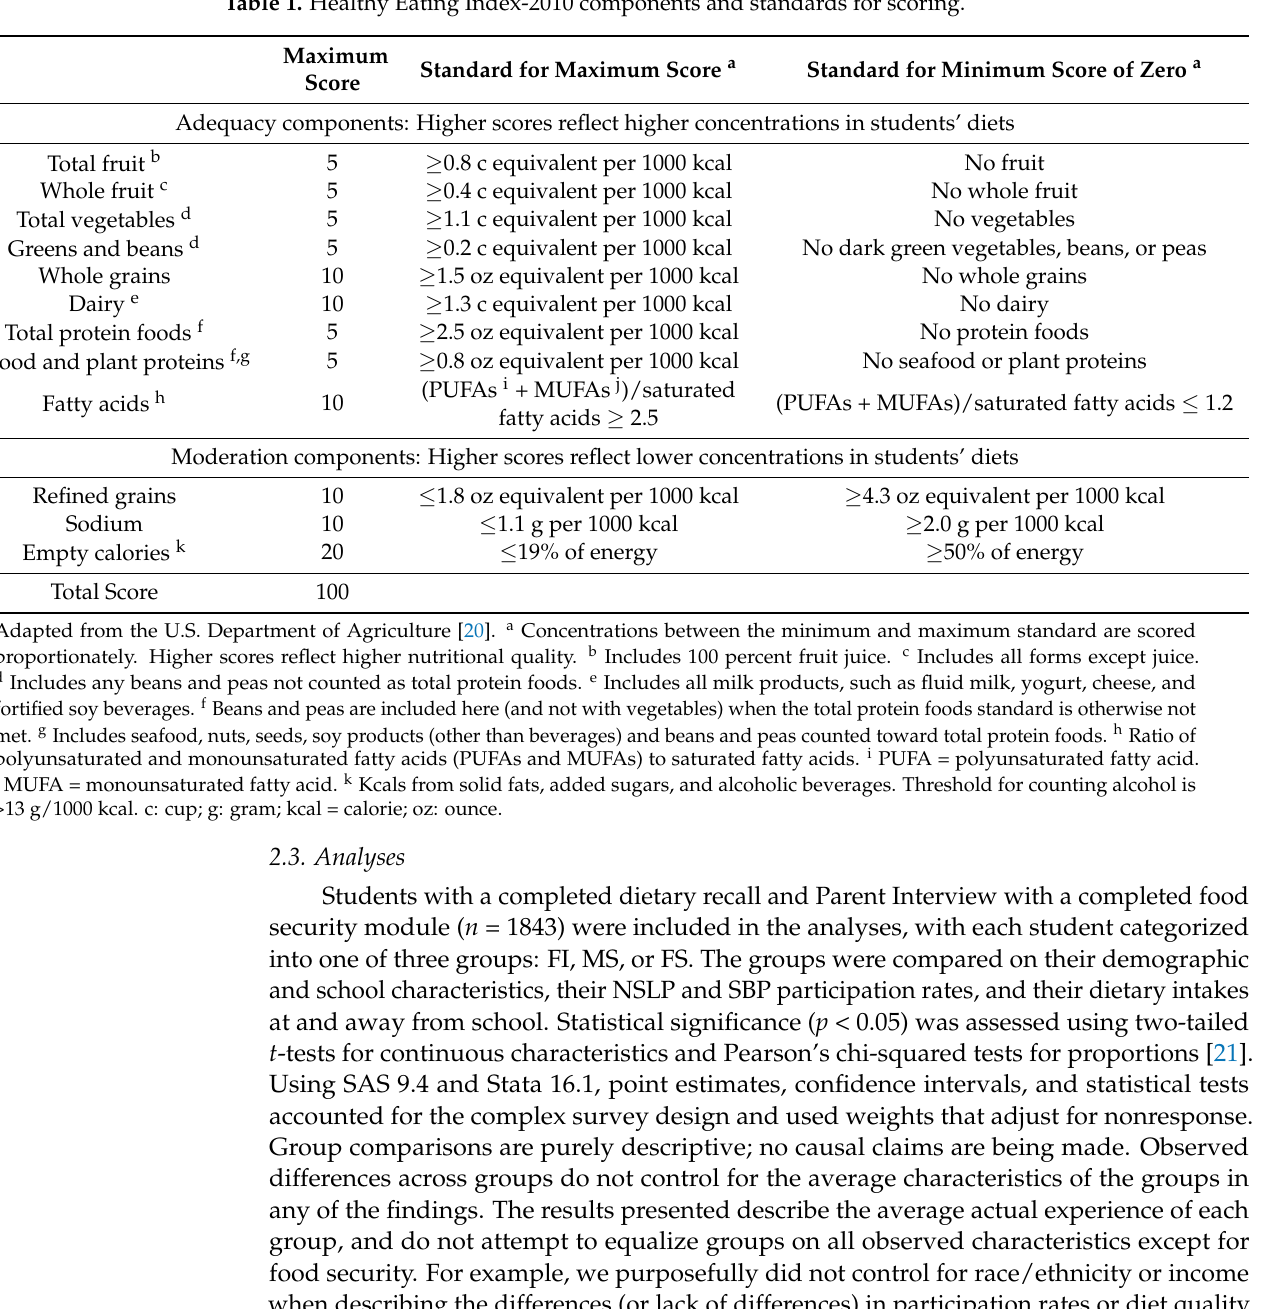
Table 1. Healthy Eating Index-2010 components and standards for